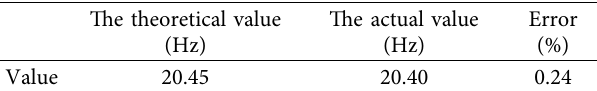
Table 7: In the condition of pose 1, Case (a), the theoretical value of the first-order natural frequency of the electrohydraulic Stewart platform is compared with the experimental value.